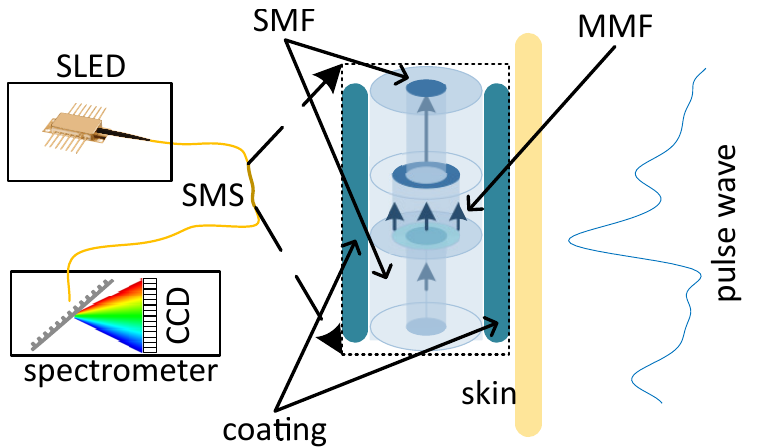
Figure 7. Schematic view of experimental setup.